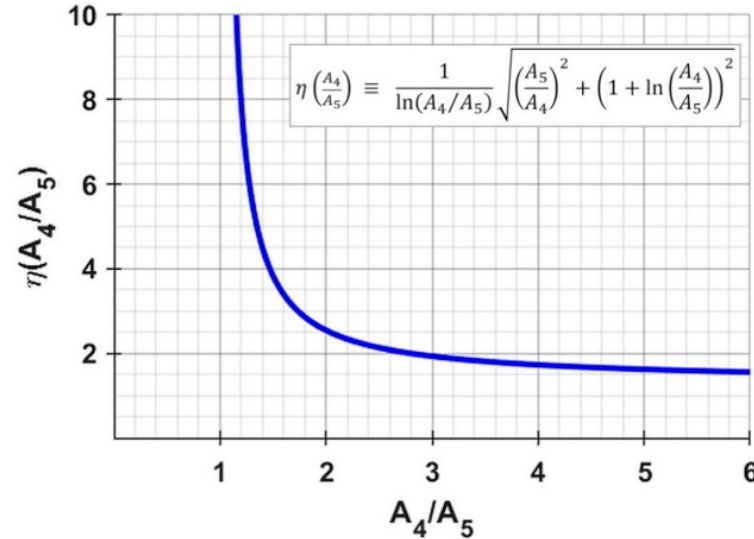
Figure A1. The function 𝜂(𝐴 (cid:2872) 𝐴 (cid:2873) ⁄ ) as defined by Equation (A4).